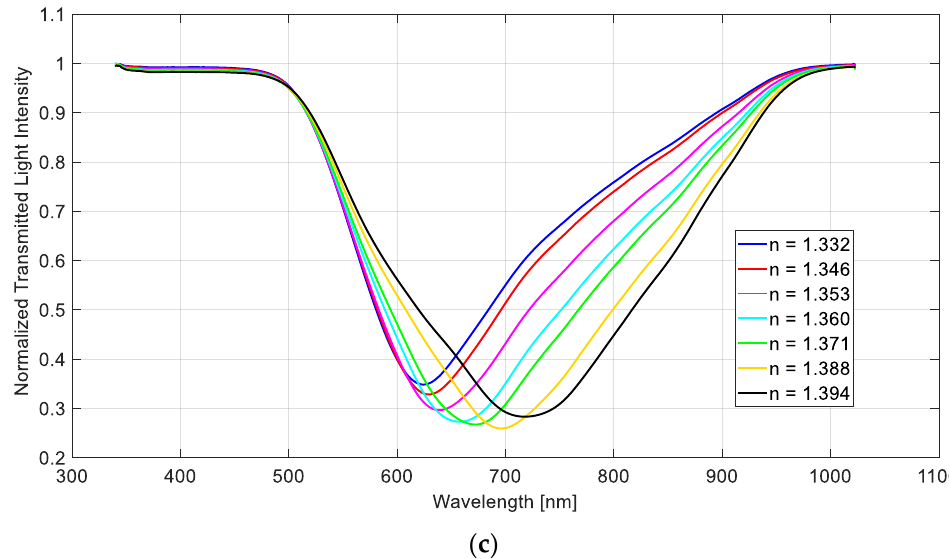
Figure 2. SPR transmitted spectra, obtained by normalization to the spectrum acquired with air as the surrounding medium, for different refractive index values. Configuration with a taper ratio equal to ( a ) 1.3, ( b ) 2.3, and ( c ) 4.6.